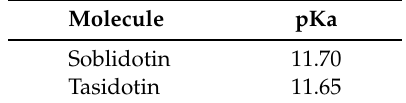
Table 3. pKa values for the anticancer marine peptides Soblidotin and Tasidotin.